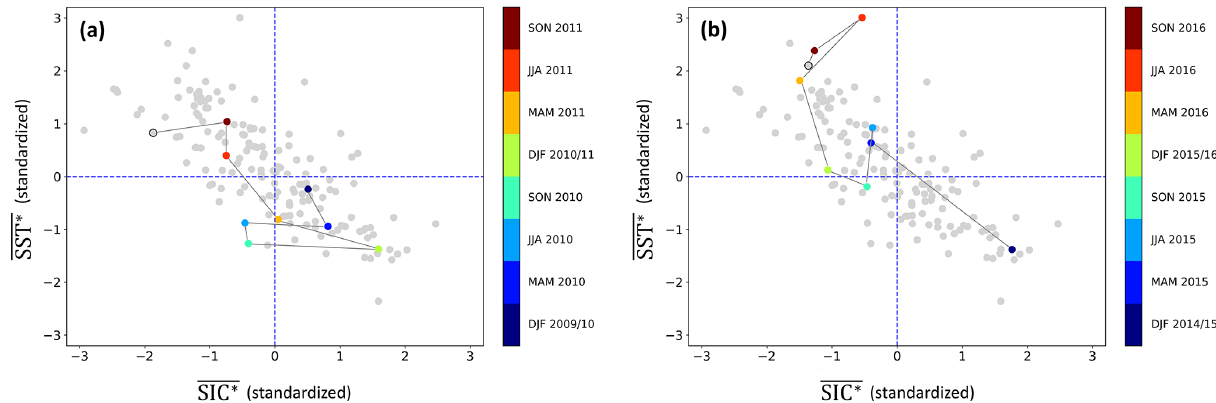
Figure 13. Standardized seasonal-mean anomalies of SIC (SIC ∗ ; along x axis) and SST (SST ∗ ; in K, along y axis) in the Kara and Barents seas for the entire study period (grey dots) including all seasons. Colored dots highlight the eight seasons preceding (a) the anomalous winter 2011/12 and (b) the extreme winter 2016/17, and the grey line shows the pathway of these seasons’ anomalies.